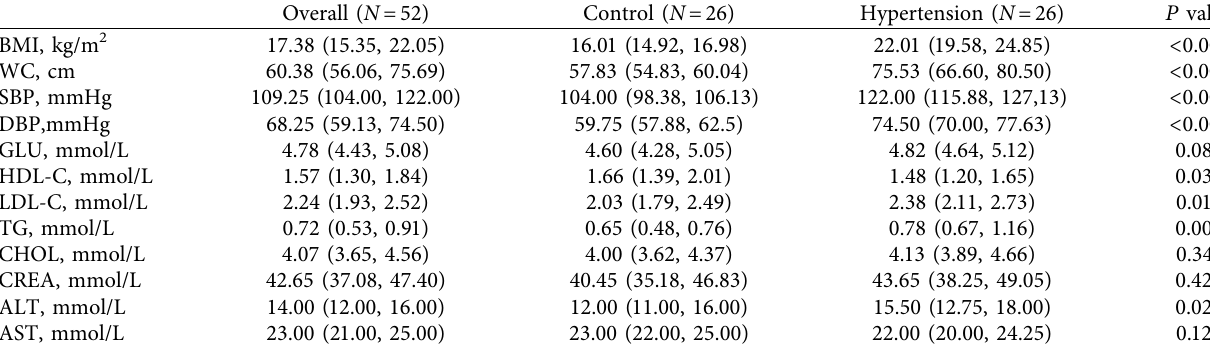
Table 1: Characteristics of study